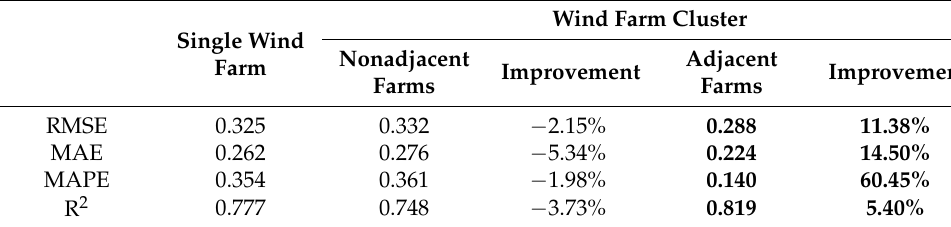
Table 5. Performance of different input datasets *.